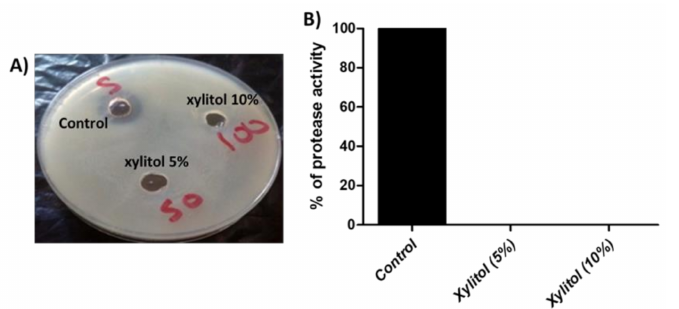
Figure 3. ( A ) Inhibition of protease activity by the skim milk agar method. The wells made in skim milk LB agar plates were inoculated with aliquots of (100 µ L) of the supernatants of xylitol- treated and untreated cultures. The clear zones around the wells were measured. The test was performed in triplicate. Xylitol completely blocked the protease activity. ( B ) The data shown are the means ± standard errors. One-way ANOVA test followed by Dunnett’s Multiple Comparison test was used for statistical